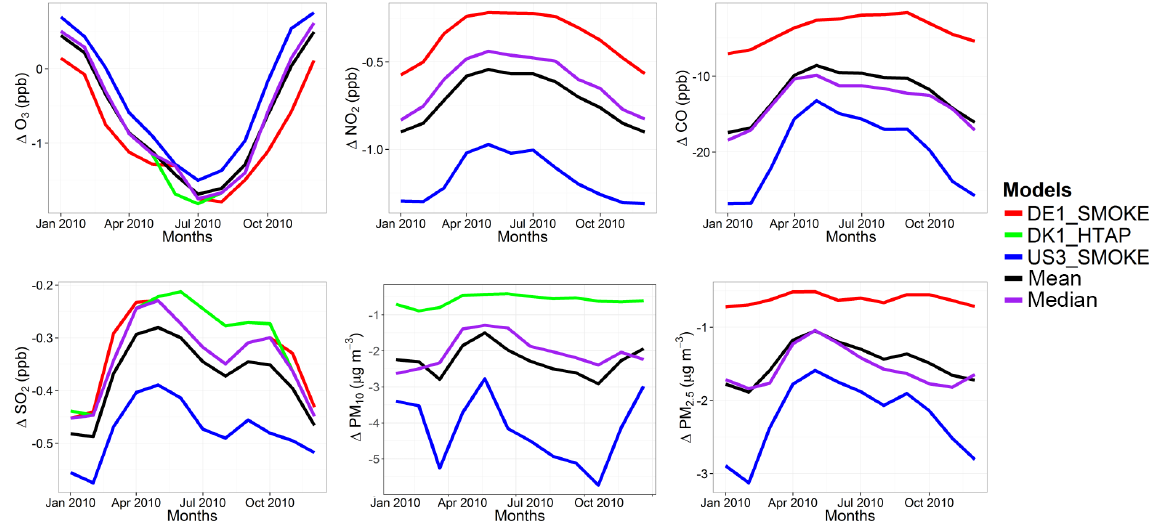
Figure 11. Absolute impact of the 20% reduction of the North American anthropogenic emissions over North America (GLO NAM − BASE NAM ).